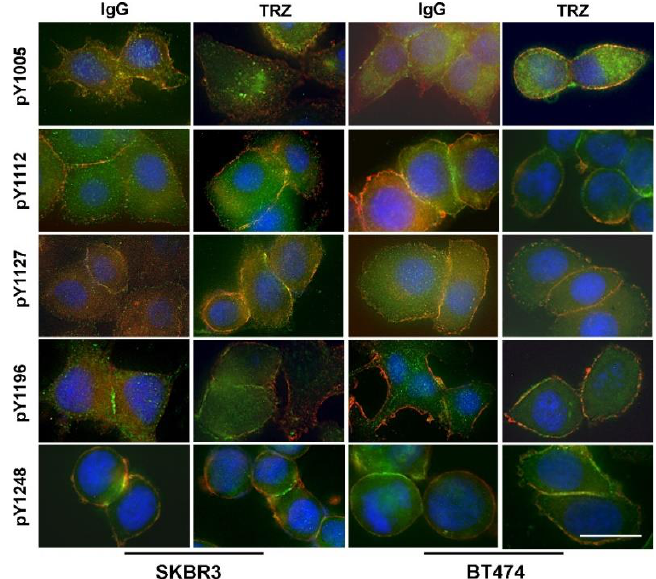
Figure 6. The effects of trastuzumab on EGF-induced phosphorylation of HER2 at various pY sites including pY1005, pY1112, pY1127, pY1196, and pY1248 in BT474 and SKBR3 cells. Cells were incubated with TRZ (10 µg/mL) or human IgG for 1 h and then stimulated with EGF (50 ng/mL) for 15 min. The phosphorylation of various HER2 pY sites (green) were determined by specific antibodies followed by FITC conjugated secondary antibody, and total HER2 (red) was revealed by anti-HER2 antibody followed by TRITC conjugated secondary antibody. Yellow indicates the co-localization. the size bar = 20 µm.